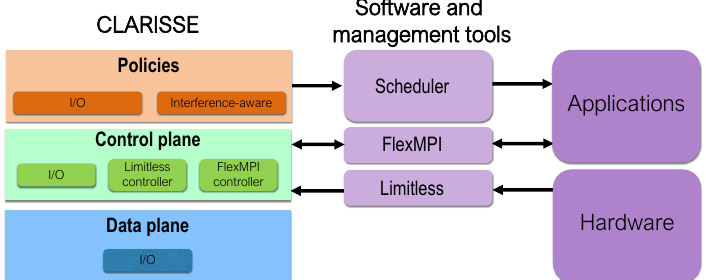
Figure 1. Diagram that illustrates the separation of data plane, control, and policy in CLARISSE and the interaction with the different software and management tools of the